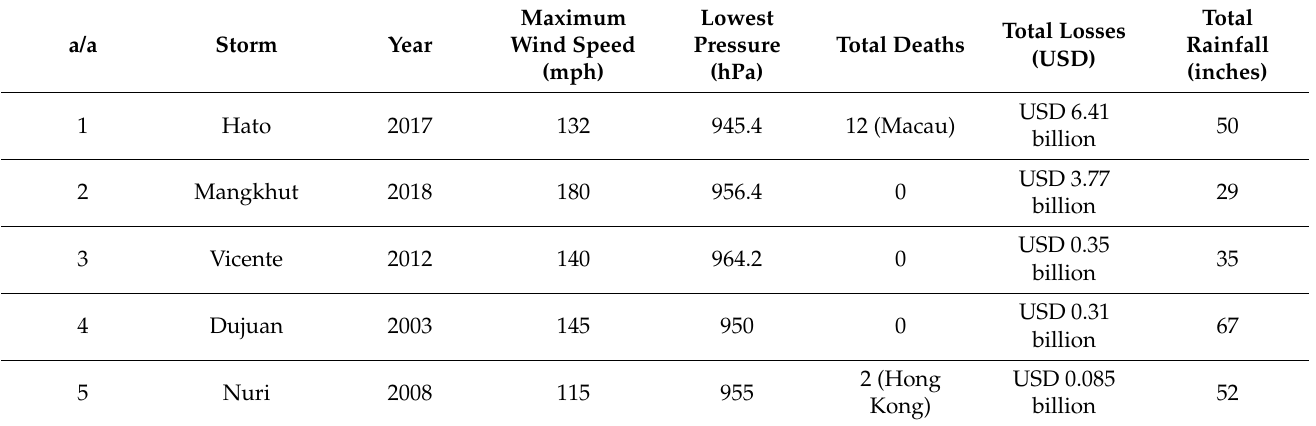
Table 6. Summary of the most severe storms in Macau and Hong Kong since